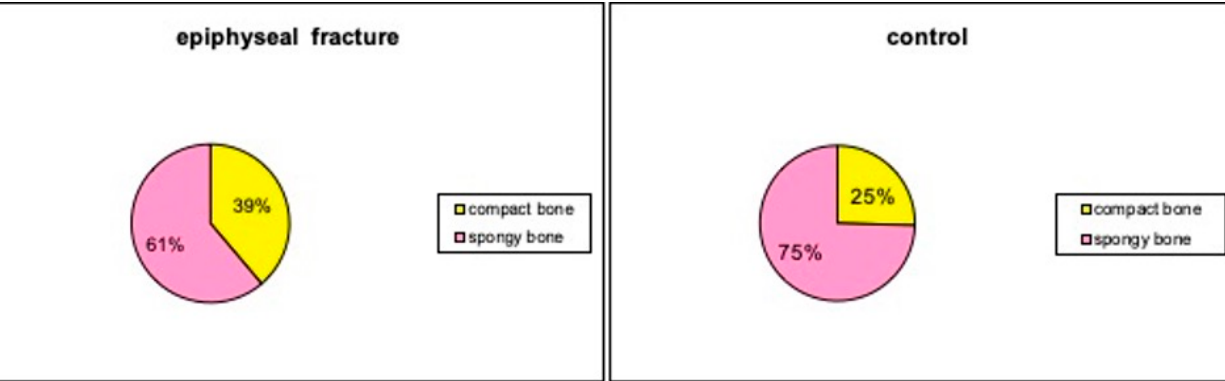
Scheme 2. Percentage areas occupied by different tissues in the fractured epiphysis and contralateral healthy.